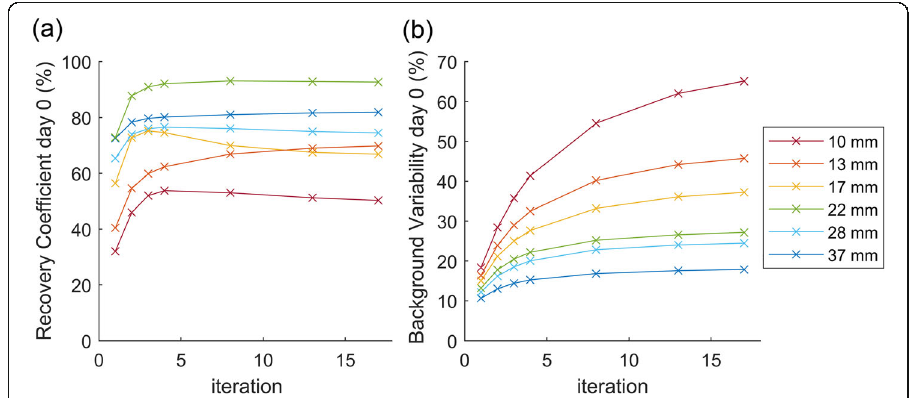
Fig. 3 Recovery coefficient ( a ) and percentage background variability ( b ) of the NEMA phantom spheres with varying diameter at day 0 (2.5·10 3 MBq) as a function of iteration